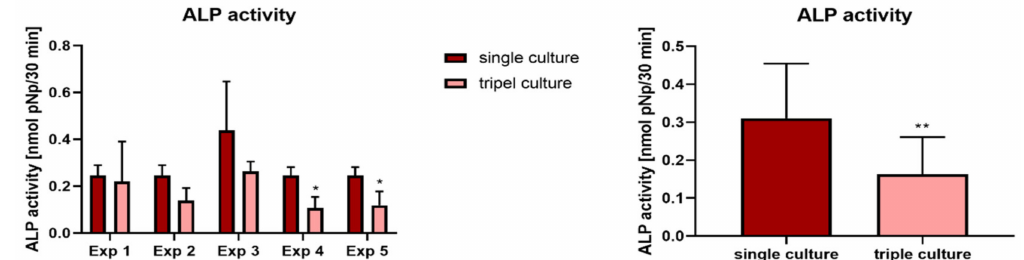
Figure 7. ALP activity of osteoblasts in single culture compared to triple cultures with osteoclasts and osteocytes. Average +/ − standard deviation for every experiment ( left ) and for all five experiments together ( right ). * p < 0.05, ** p <